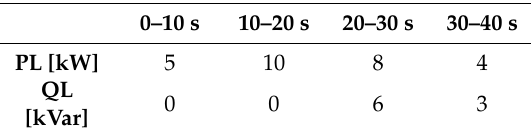
Table 4. Simulation